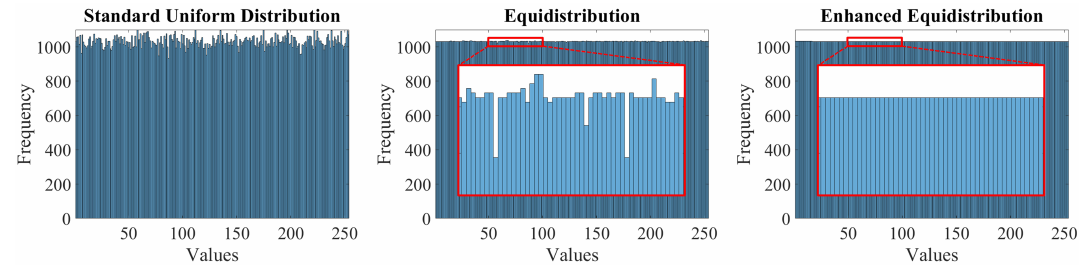
Figure 4. Histograms of data drawn from standard uniform distribution, equidistribution, and enhanced